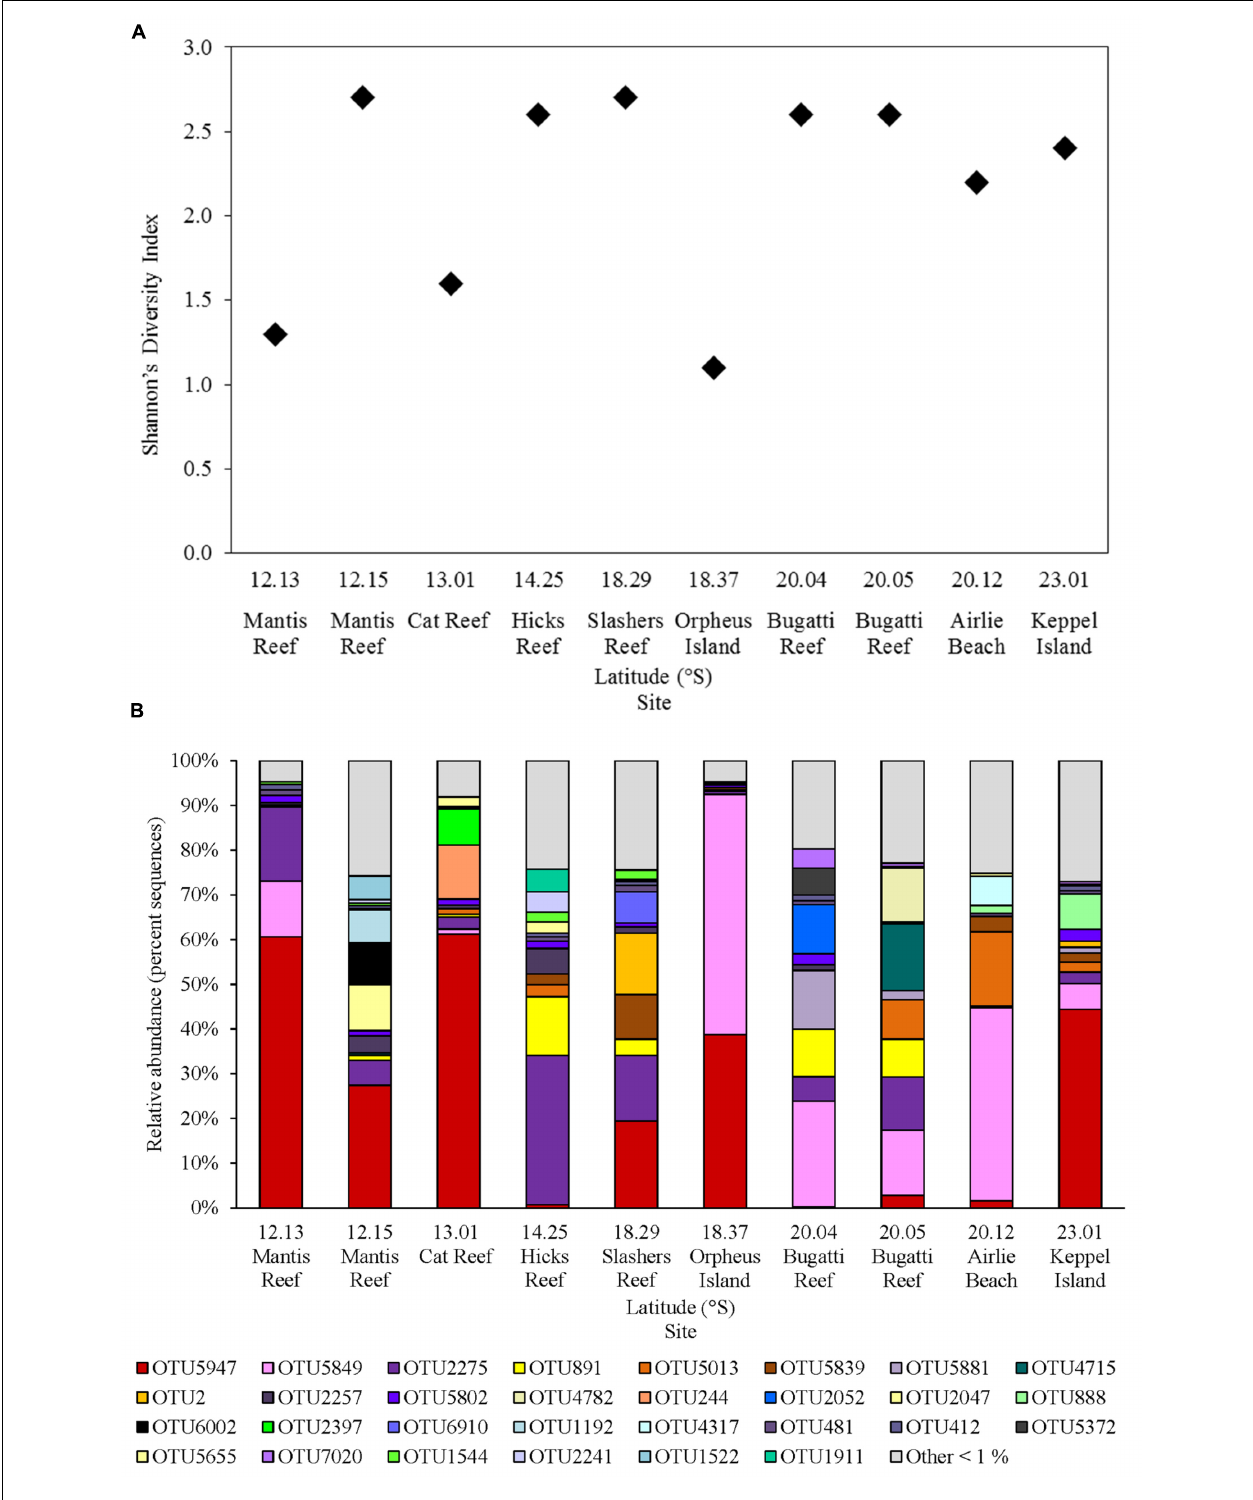
FIGURE 4 | Diazotroph assemblages within GBR surface waters, including (A) nifH diversity (Shannon’s index) of rarefied sequence data and (B) relative abundance of nifH OTUs (% of total sequences) clustered at 97% sequence similarity, with OTUs representing < 1% of total sequences grouped as “Other < 1%.”